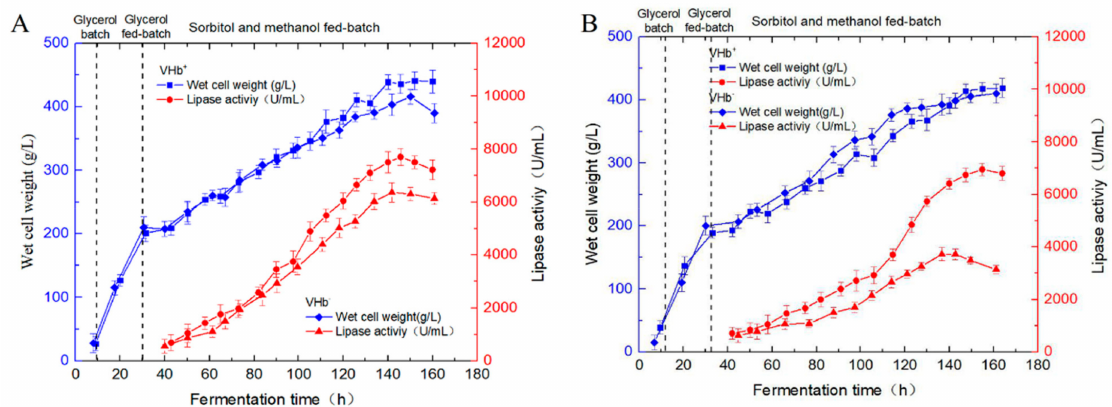
Figure 5. ( A ) Comparison of wet cell weight and lipase activity for GS115 / pAO α -2lip2 #15 and GS115 / 2lip2-ZAvgb #13 in a 3 L fermenter under the higher dissolved oxygen (DO) concentration (about 50%). ( B ) Comparison of wet cell weight and lipase activity for GS115 / pAO α -2lip2 #15 and GS115 / 2lip2-ZAvgb #13 in a 3 L fermenter under the lower DO concentration (about 10%). Data are the mean ± standard deviation of triplicate